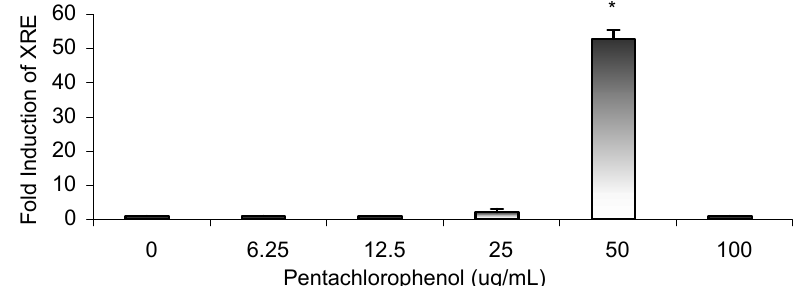
Figure 3. Fold induction of XRE in HepG transfected with a XRE gene promoter fused to the CAT protein were treated with serial dilutions of PCP (0-100 µ